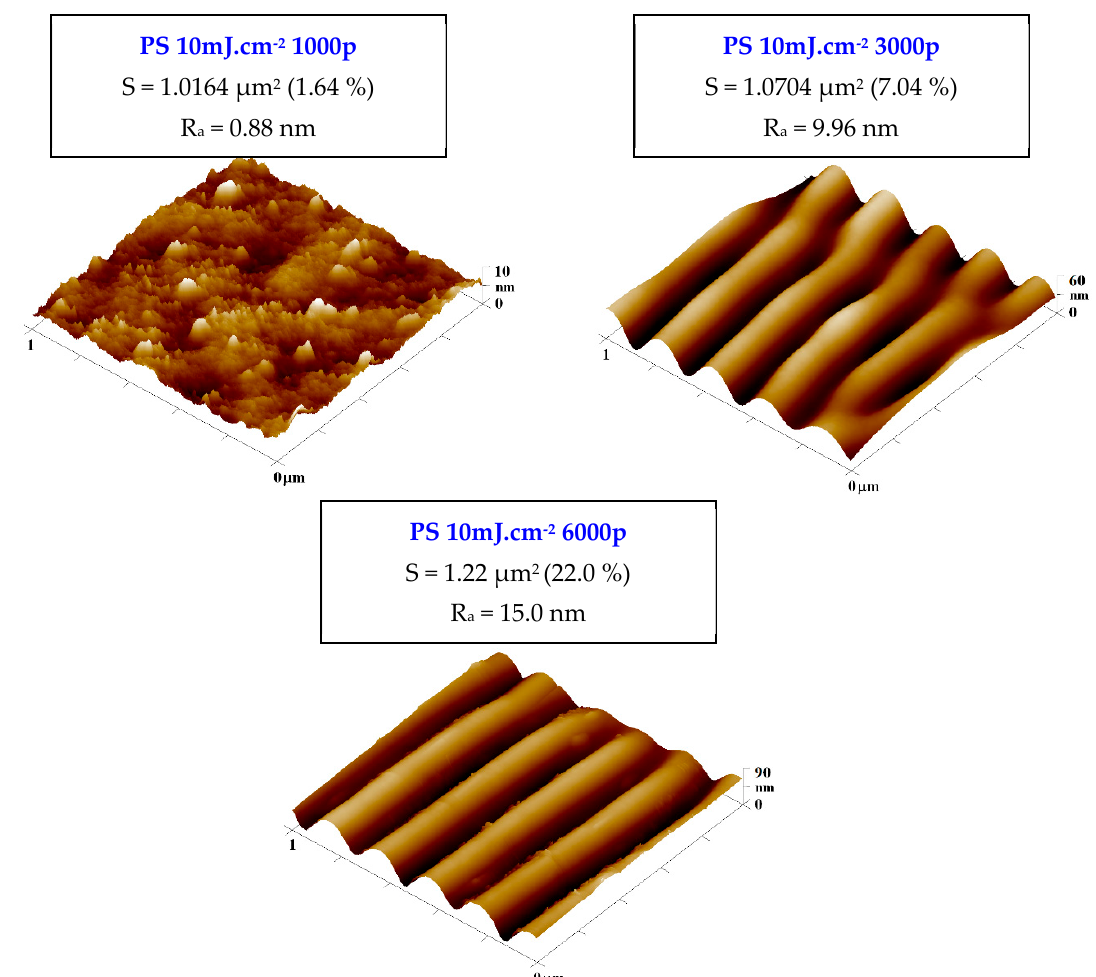
Figure 5. Atomic force microscopy images of PS foil treated by KrF laser with the laser fluence of 10 mJ·cm − 2 and 1000, 3000, and 6000 pulses. The Ra represents surface roughness and S the effective surface area.